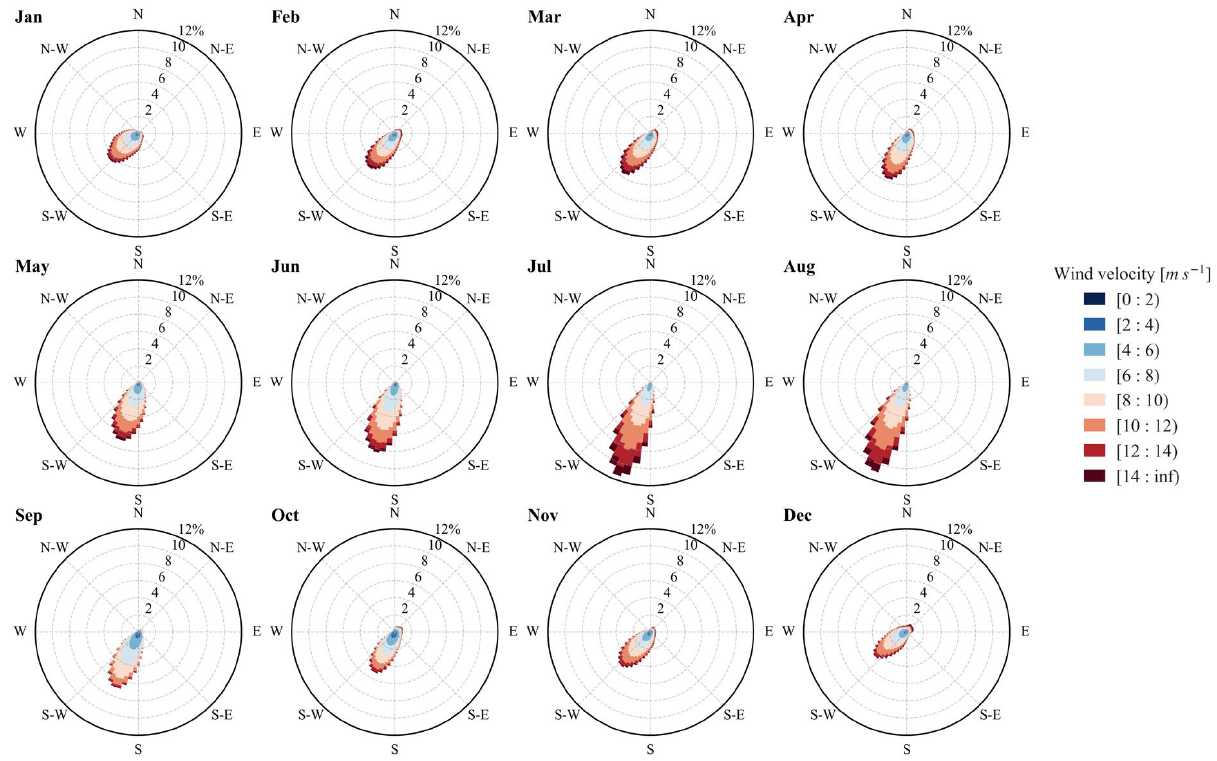
Figure 5. Simulated monthly 100m wind climatologies for 2006–2015 in CRS1 over the analysis region defined in Fig. 2a based on hourly data in CRS1. The wind roses can be understood as histograms of wind direction that simultaneously take into account wind velocity varying from 0 to more than 14ms − 1 . Each sector with a width of 5 ◦ points in the direction of the wind, and its radius represents the frequency.